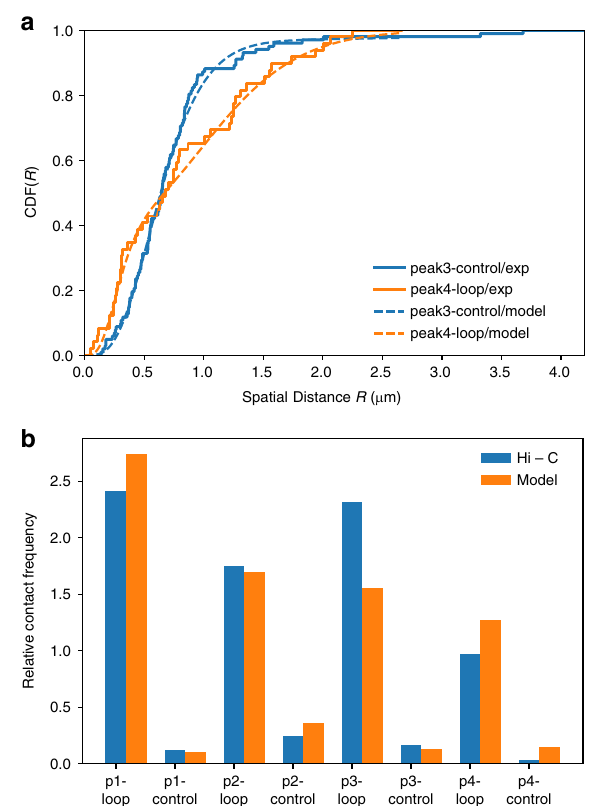
Fig. 4 Extracting statistics of subpopulations from FISH data. a Cumulative distribution function of the spatial distance, CDF( R ) for two pairs of loci, labeled peak3-control and peak4-loop in ref. 6 . The excellent agreement between theory and experiments shows the usefulness of the relationship between P mn and R mn obtained using GRMC. The solid curves are the R R experiment data 6 . The dashed lines are the fi ts to P ð r Þ d r (the 0 needed expressions are in Eq. (3) and Supplementary Eq. (1)). The best fi t parameters are η ≈ 0.97, 〈 R 〉 ≈ 0.67 μ m, peak3 − control 1,peak3 − control 〈 R 〉 ≈ 4.08 μ m, η ≈ 0.42, 〈 R 〉 ≈ 0.30 μ m and 2,peak3 − control peak4 − loop 1,peak4 − loop 〈 R 〉 ≈ 1.21 μ m. b Relative contact frequency computed from the fi ts 2,peak4 − loop of CDF( R ) for eight pairs of loci investigate experimentally 6 (orange bars). R r c P ð r Þ d r For each pair of loci, the contact probability is calculated as P mn ¼ 0 (Eq. (3)) using the parameters obtained by fi tting CDF( R ) with r c = 20nm. Comparison of the CDF( R )s between theory and experiments for the eight pairs of loci are displayed in Supplementary Fig. 2. Blue bars are computed using the contact number from Hi-C measurements in ref. 6 . The relative contact frequency is calculated as Pi / 〈 P 〉 , where Pi is the contact probability computed using the model or the contact number measured in Hi-C for i th pair, and 〈 P 〉 is the mean value for all the pairs considered. p1-loop/p1- control/ … are the ones referred to peak1-loop/peak1-control/ … in ref.